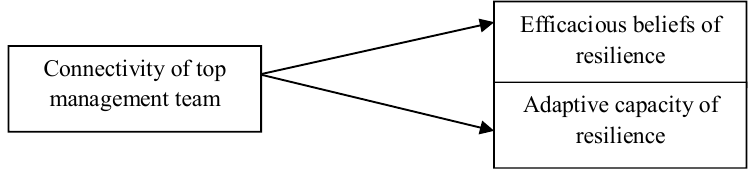
Fig. 1. Conceptual model of research (Adapted from Carmeli et al.,